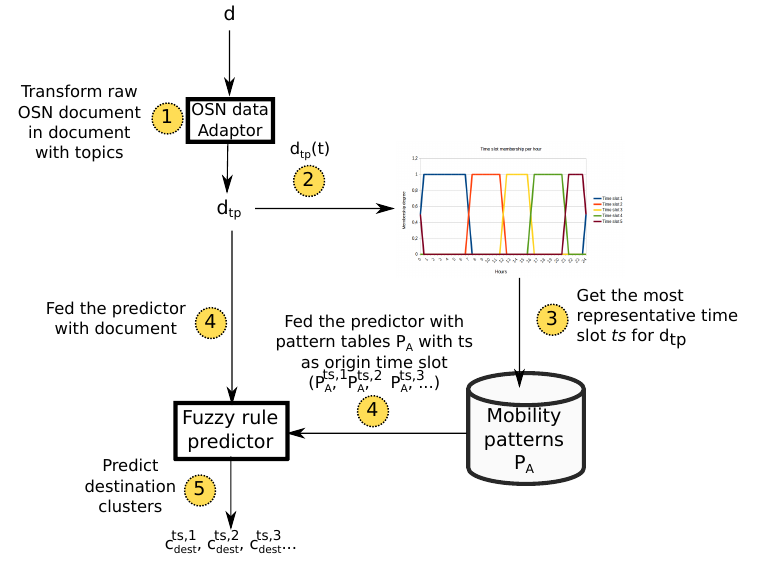
Figure 5. Workflow of the prediction